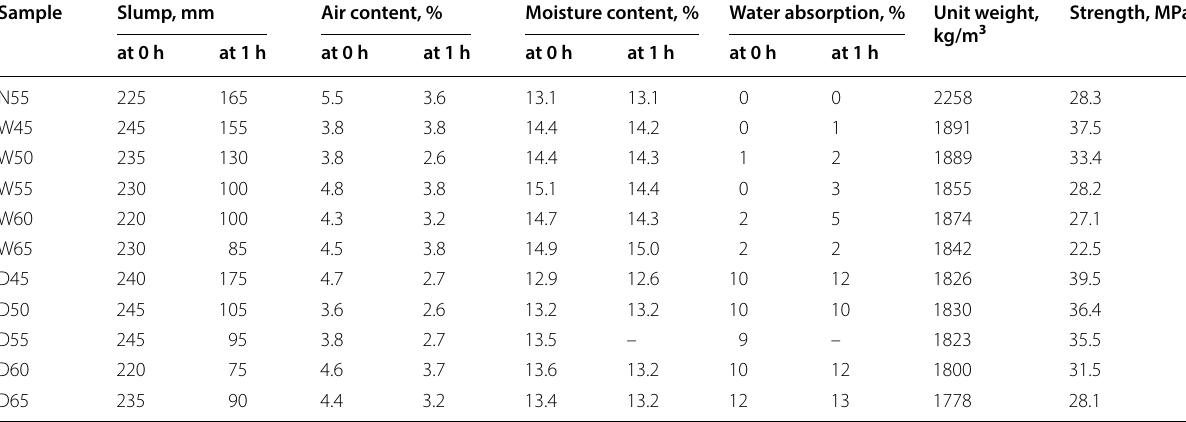
Table 3 Properties and test results of the concrete samples.